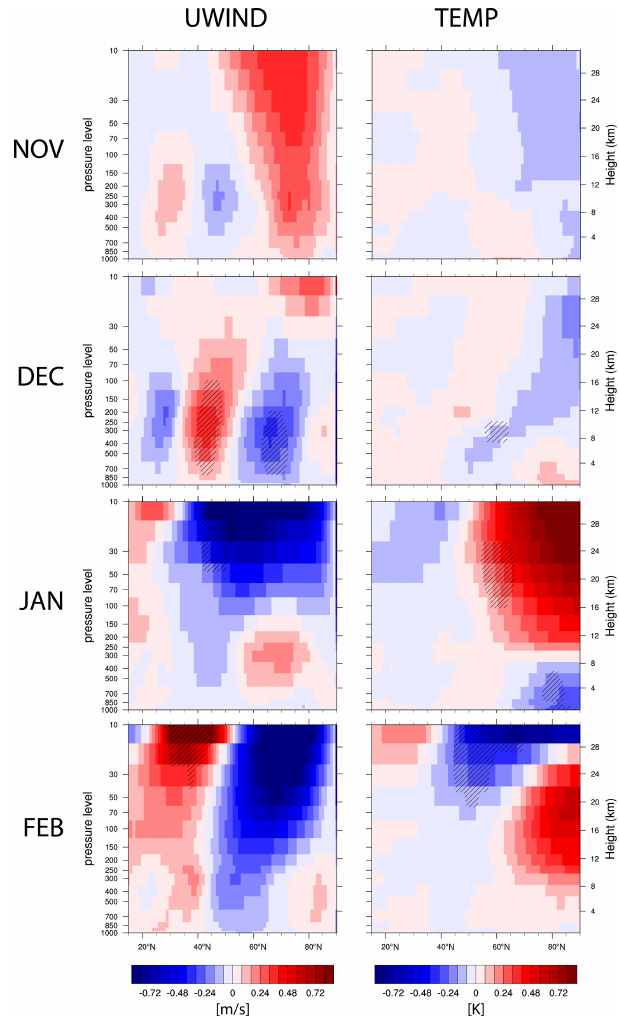
Figure 7. Zonal-mean cross section of (left) zonal wind anoma- lies and (right) temperature anomalies for the period 1901–2010 be- tween high-dipole and low-dipole ASF-20C EXP ensemble means. Shading indicates 90% significance